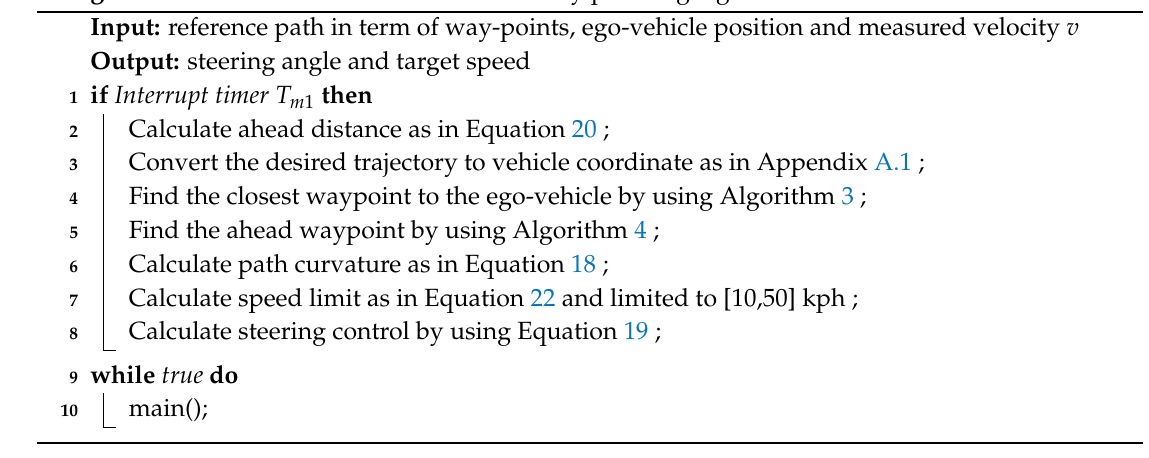
Algorithm 2: The lateral controller and velocity planning algorithm based on PPC.